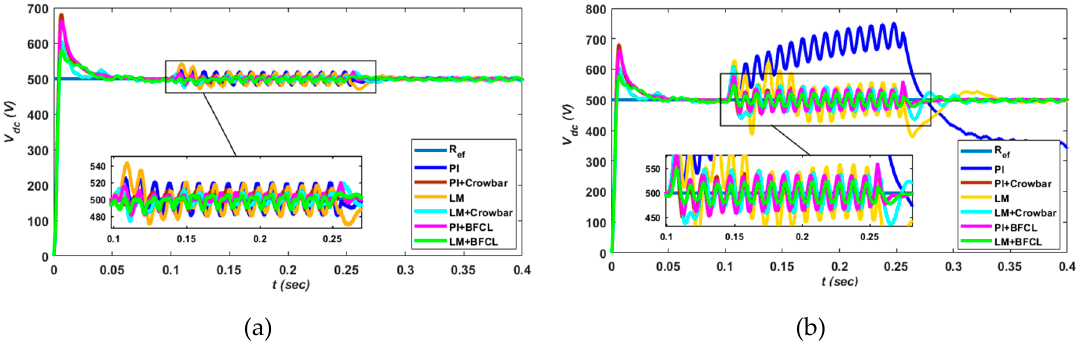
Figure 21. DC-link voltage during P-G fault 21 ( a ) and P-P fault 21 ( b ) at 15-km from PCC.